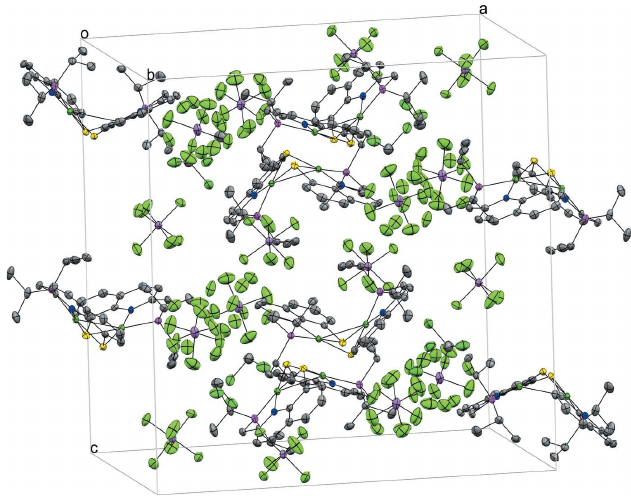
Figure 4 A partial packing diagram of 2(SBF 6 ) 2 ; H atoms, and solvent omitted for clarity.